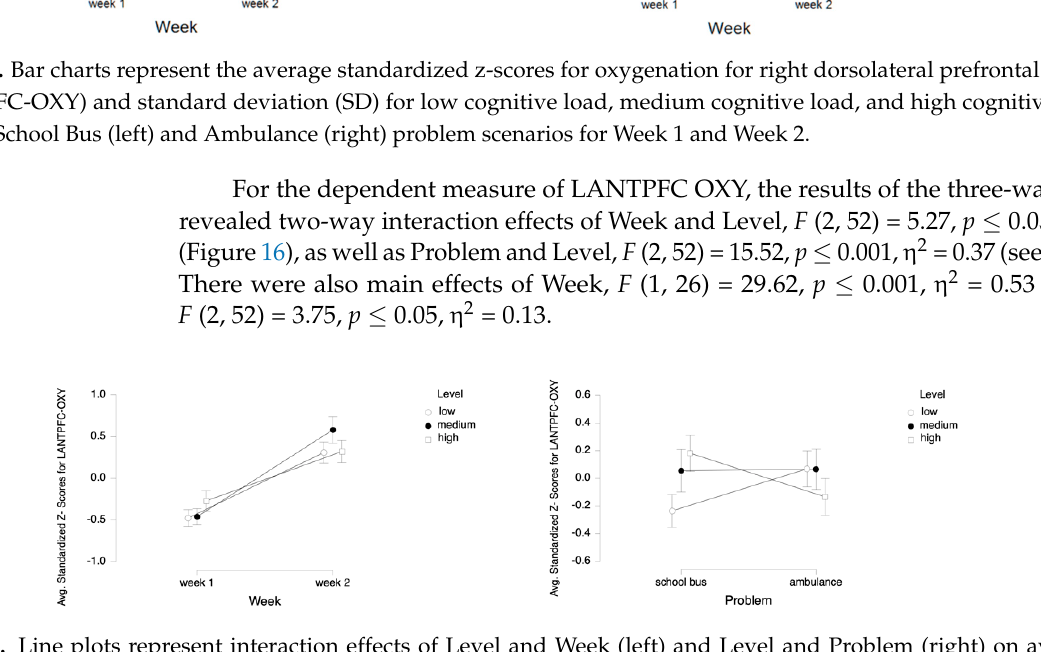
Figure 16. Line plots represent interaction effects of Level and Week (left) and Level and Problem (right) on average standardized z scores for oxygenation for left anterior prefrontal cortex (Z-LANTPFC-OXY) with the error bars representing the standard error of the mean statistic. Differences in average oxygenation for Z-LANTPFC are represented across low, medium, and high cognitive load tasks for Week 1 and Week 2 and for School Bus and Ambulance problem